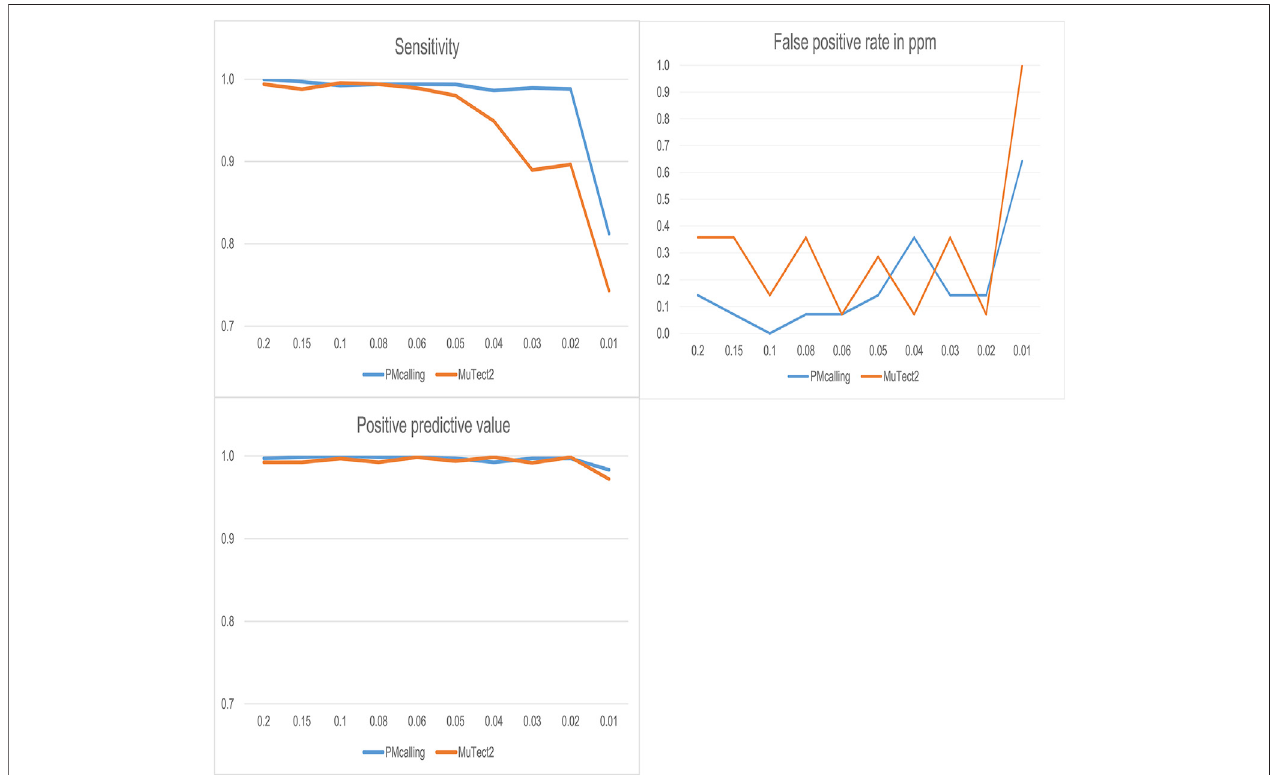
FIGURE3| Comparison ofPMdetection betweenPMcalling andMutect2withsimulateddatasets.ThesensitivityiscalculatedbydividingthepositivePMnumber found in the result by the total number of positive PM in simulated datasets for each frequency. The Positive predictive value is calculated by dividing the positive PM number found in the result by the total number of PM (positive and false positive) found for each frequency. The false positive rate is converted into the false positive PM number per million basepairs found in simulated datasets for each